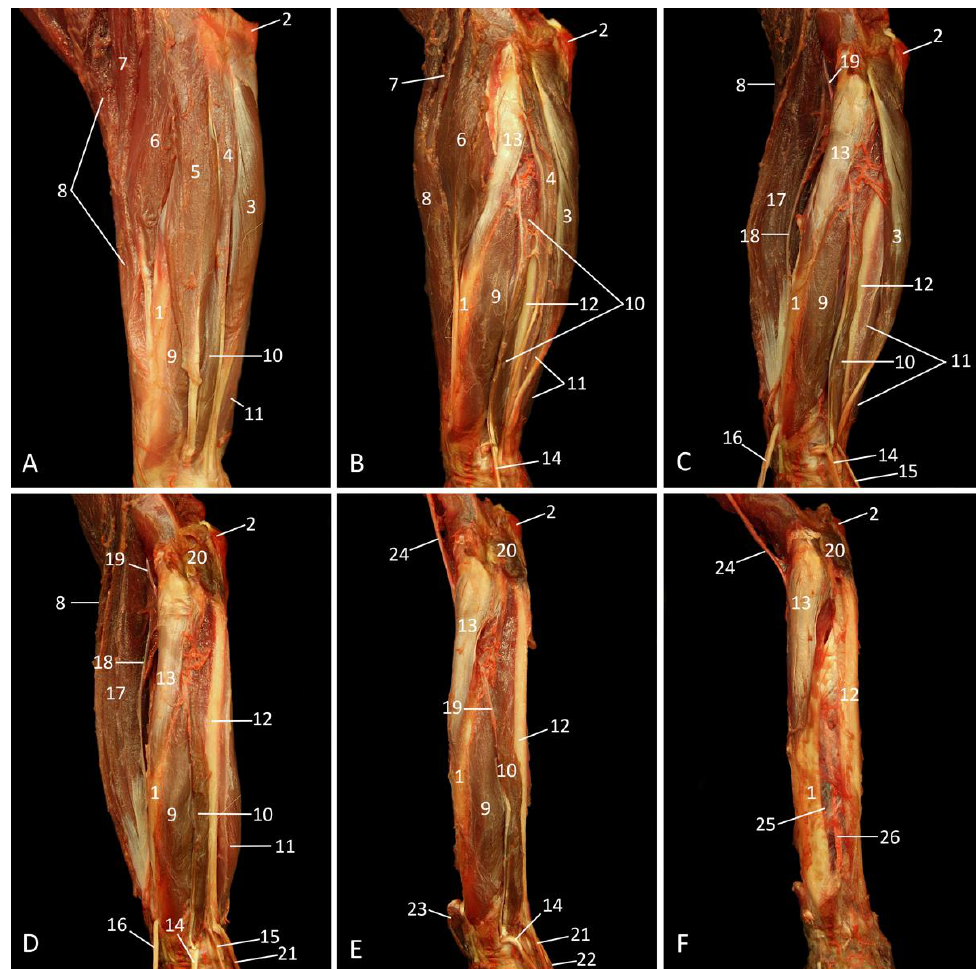
Figure 8. Lateral view of the left forearm; the arterial system is filled with red latex. ( A ): Superficial layer; ( B ): Second layer, after retraction of the m. extensor digitorum communis; ( C ): Third layer, after the removal of the m. extensor digitorum quarti et quinti and the m. extensor carpi radialis brevis; ( D ): Fourth layer, after excision of the m. extensor carpi ulnaris, ( E ): Fifth layer; after the m. brachioradialis, the m. extensor carpi radialis longus, and the m. flexor carpi ulnaris have been removed; ( F ): Deepest layer, after amputation of the m. extensor digitorum secundi et tertii proprius and the m. abductor digiti primi longus.